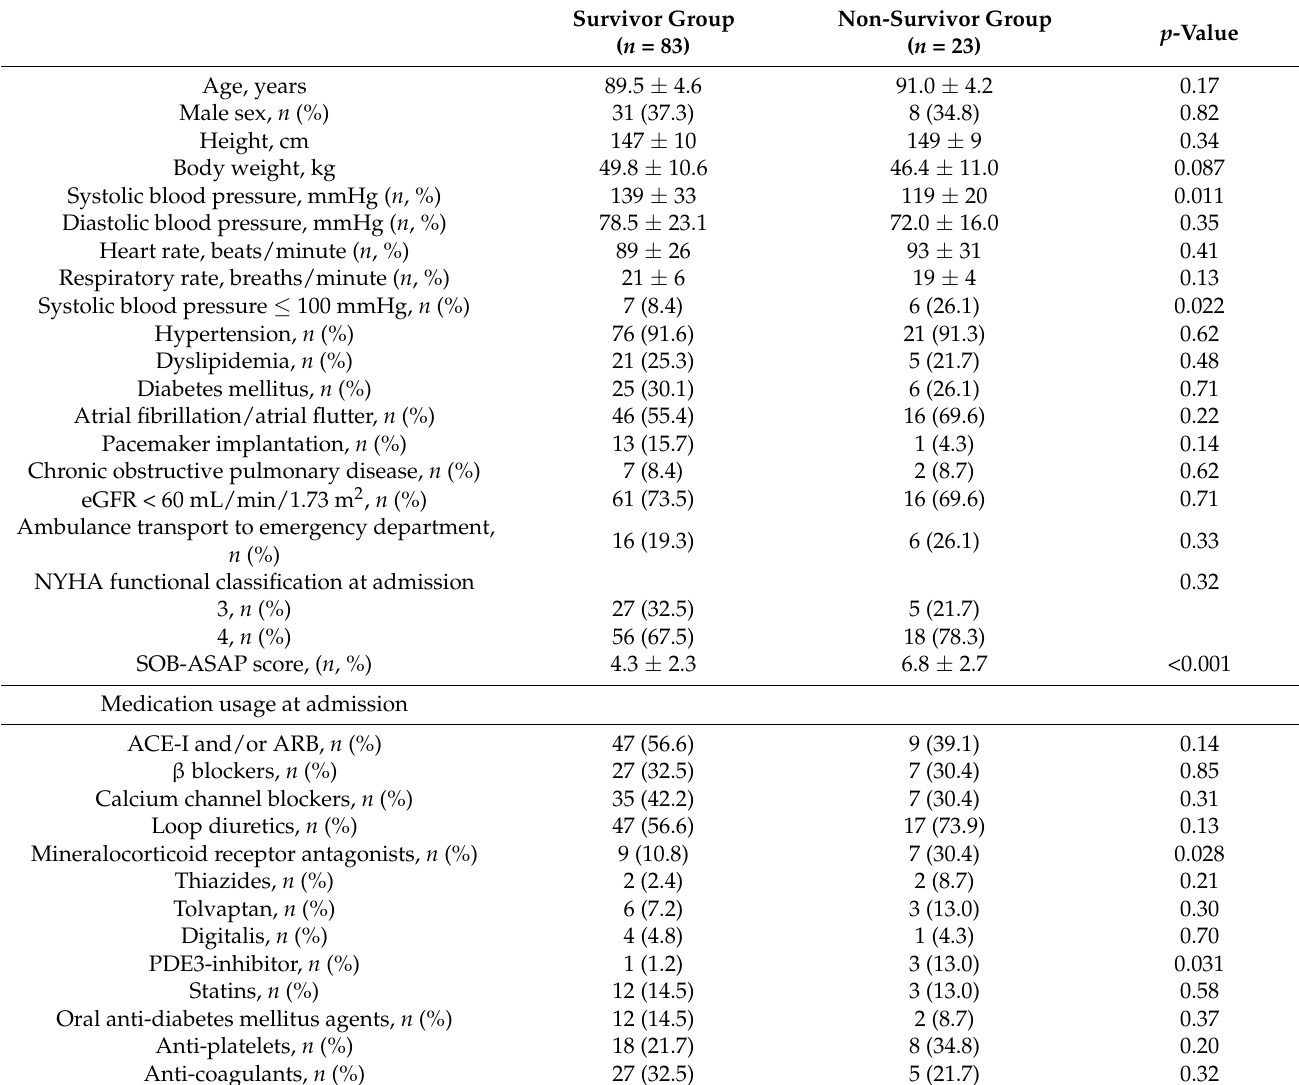
Table 1. Comparison of the baseline characteristics and medication usage at admission between the survivor and non- survivor groups.